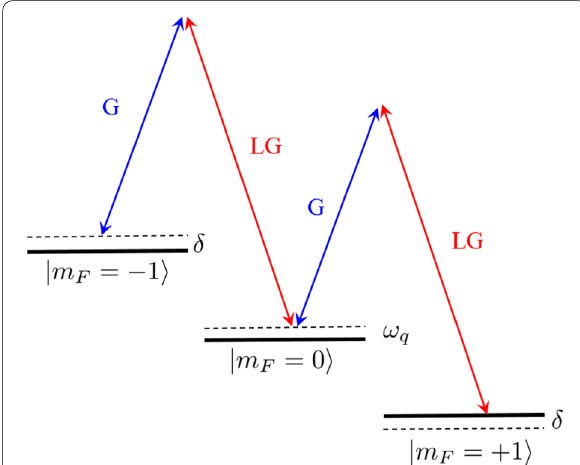
Fig. 13 The schematic of energy‑level diagram of Raman transition in [53]. The hyperfine states of the ground‑state manifold 87 Rb atoms are coupled by a pair of Raman beams, in which one is a LG beam denoted by “LG” and the other one is a Gaussian beam denoted by “G.” Here, δ is the Raman detuning that is tunable in the 2 π 50 Hz is the quadratic Zeeman experiment, and ω q ≈ ×